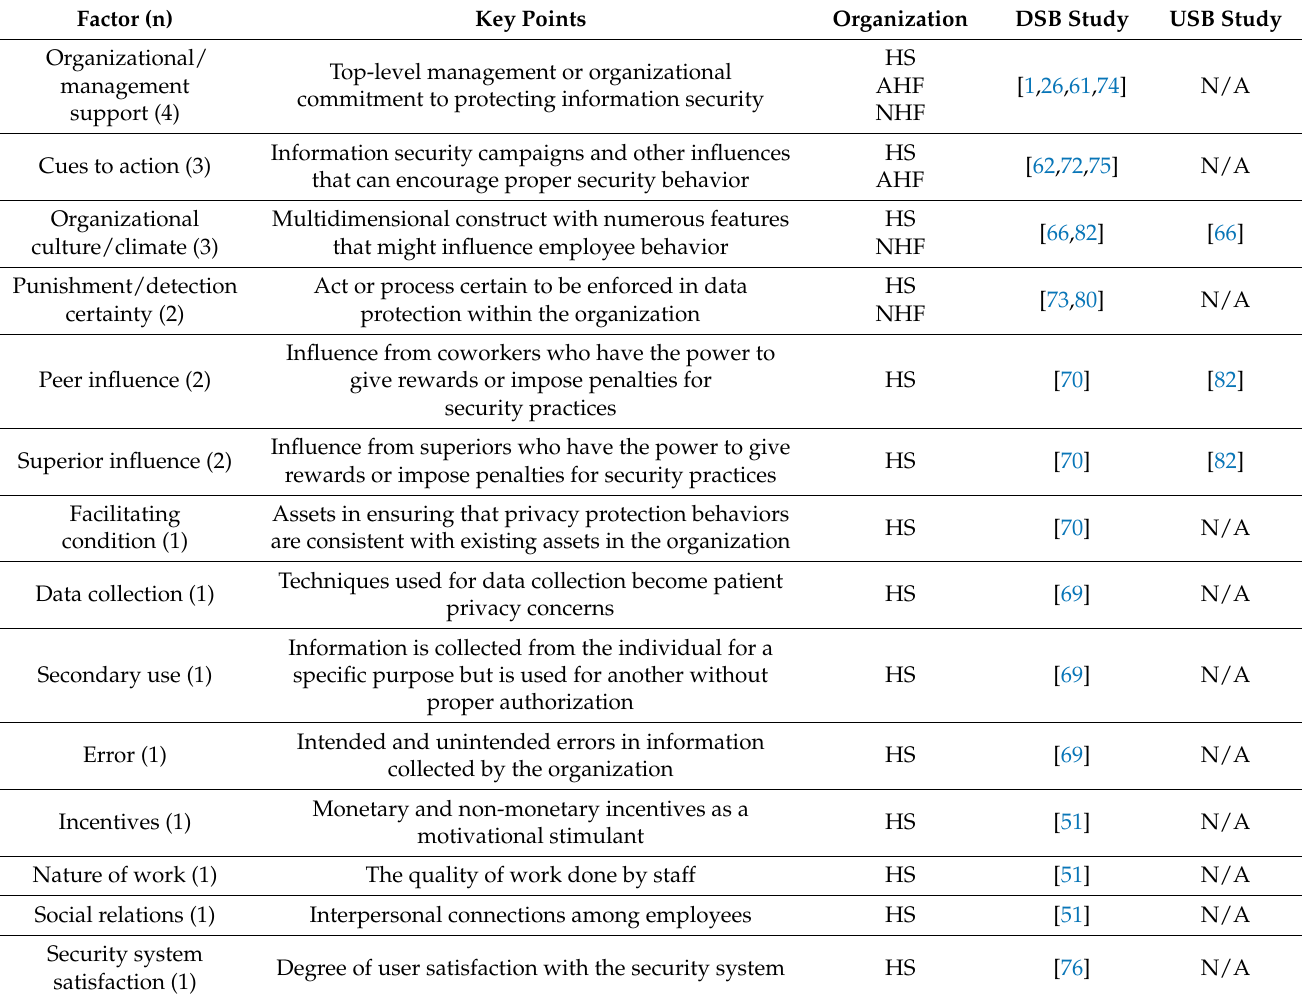
Table 9. Organizational factors as antecedents of security